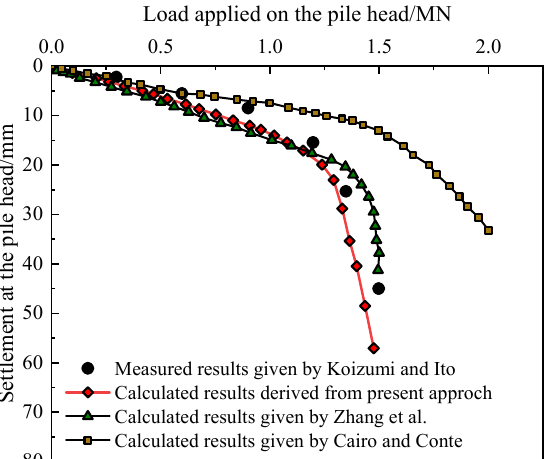
Figure 8. Comparison of the predicted and measured load–settlement curve for the group piles [2,27,28].